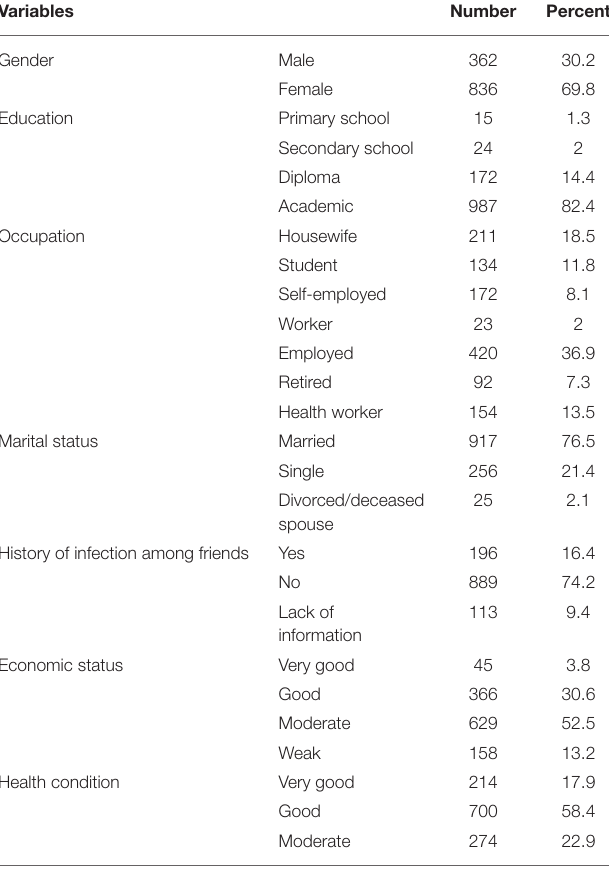
TABLE 1 | Frequency distribution of demographic variables of participants.